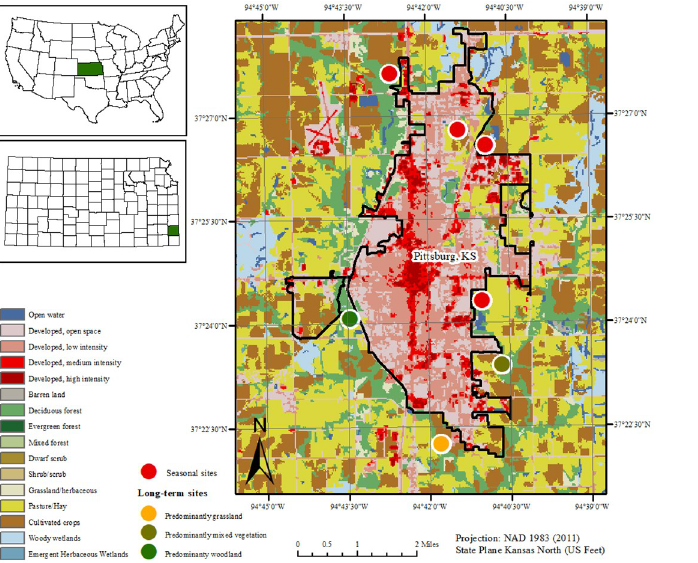
Fig 1. Short and long-term tick collection sites around Pittsburg,